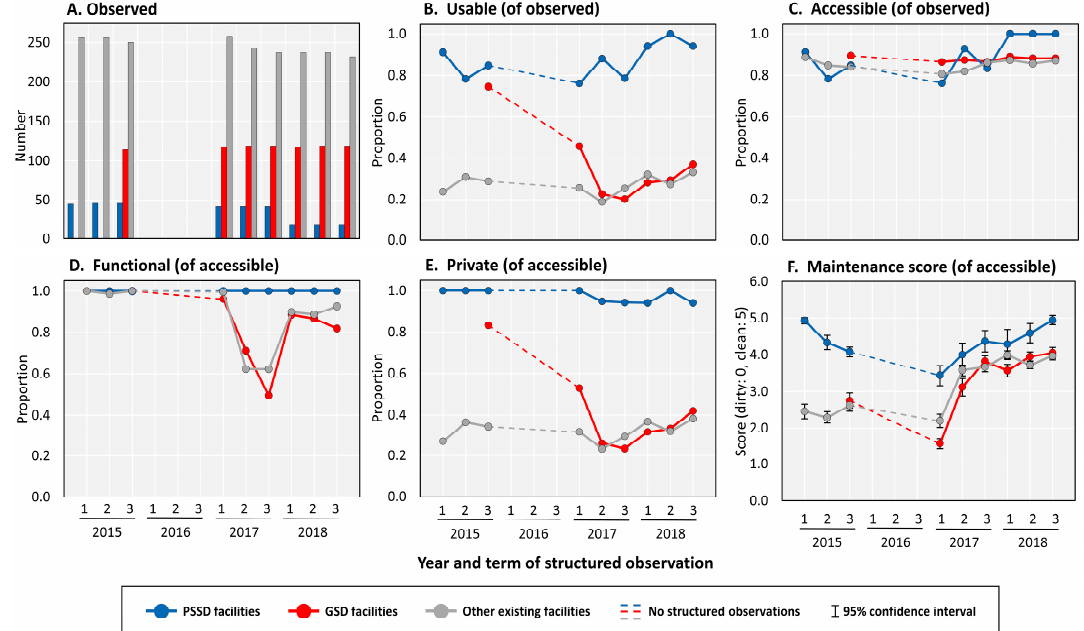
Figure 2. Comparisons of sanitation delivery modalities in urban informal settlement